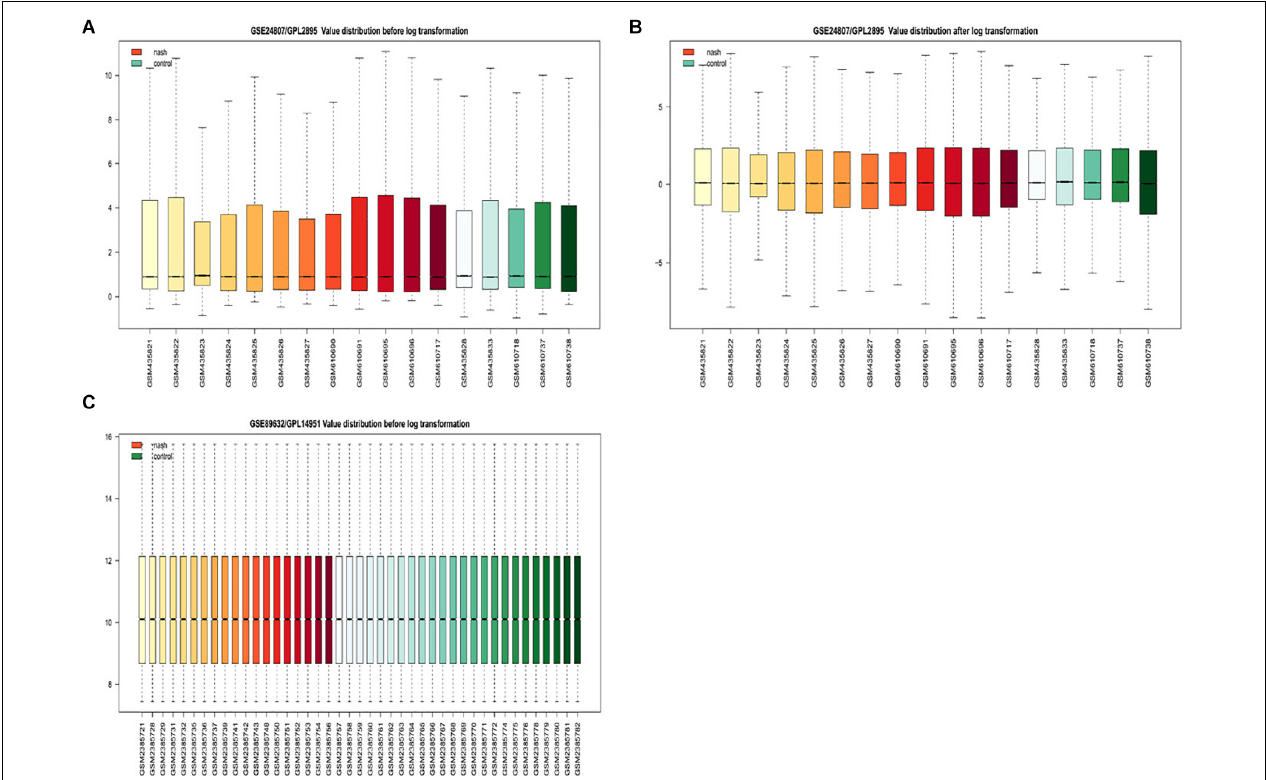
FIGURE 2 | Examination of gene expression data normalization. (A) Shows GSE24807/GPL2895 Value distribution before log transformation, red for nonalcoholic steatosis hepatitis green for healthy control. (B) Shows GSE24807/GPL2895 Value distribution after log transformation, red for nonalcoholic steatosis hepatitis green for healthy control. (C) Shows GSE89632/GPL14951 Value distribution after log transformation, red for nonalcoholic steatosis hepatitis green for healthy